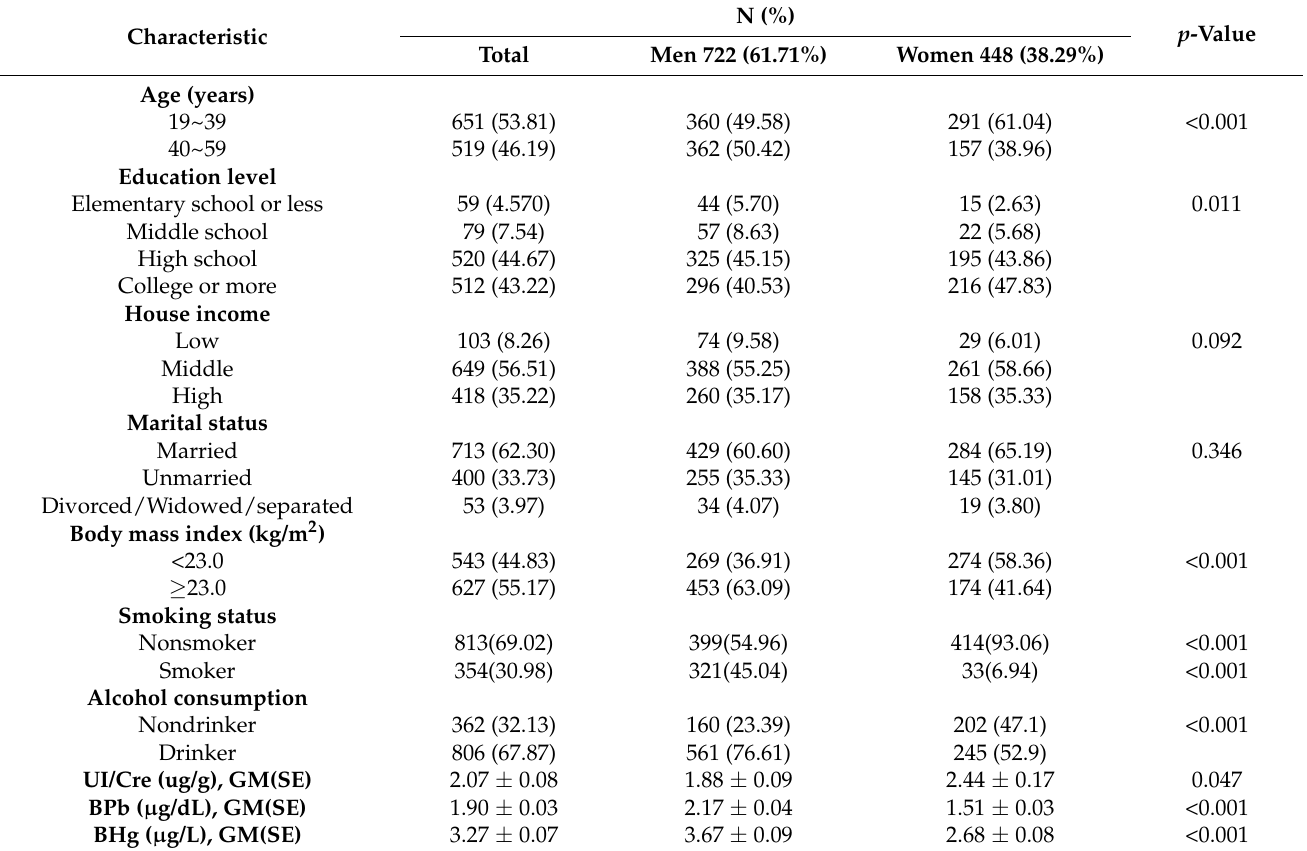
Table 1. Characteristics of study population in KNHANES study (n = 1170).